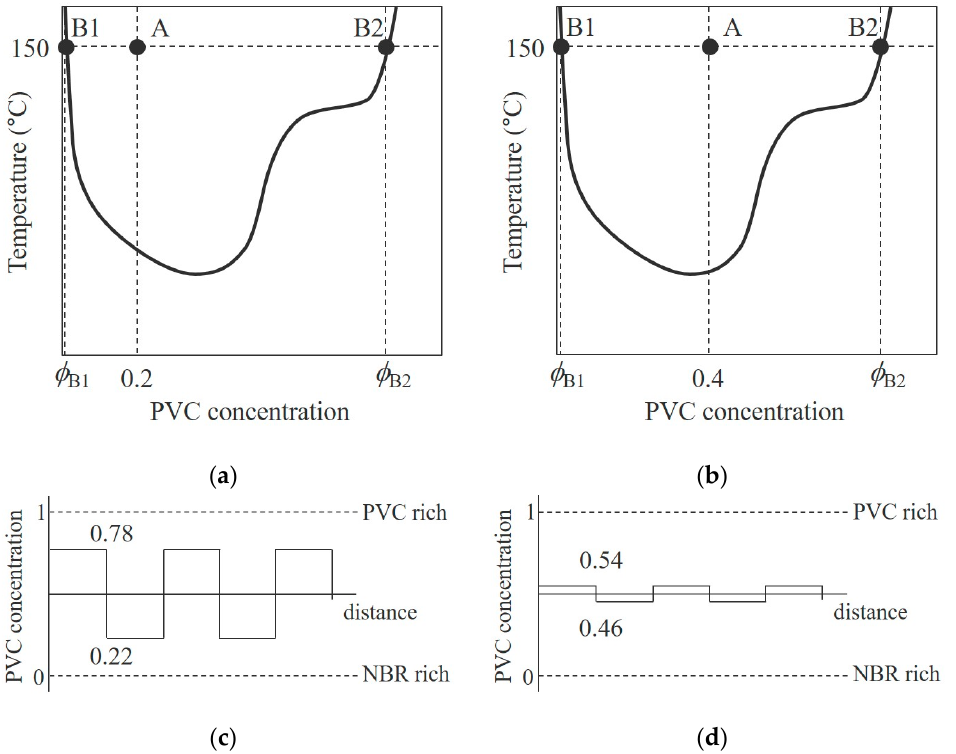
Figure 8. Schematic illustrations of phase diagram and concentration distribution in the NBR/PVC blends: ( a , c ) φ A = 0.2, ( b , d ) φ A = 0.4.